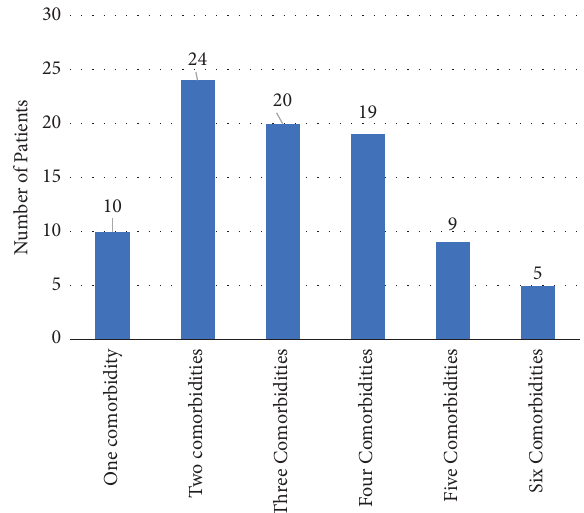
Figure 4: Number of comorbidities among patients with DM admitted to JMC from October 01, 2020, to June 30, 2021.